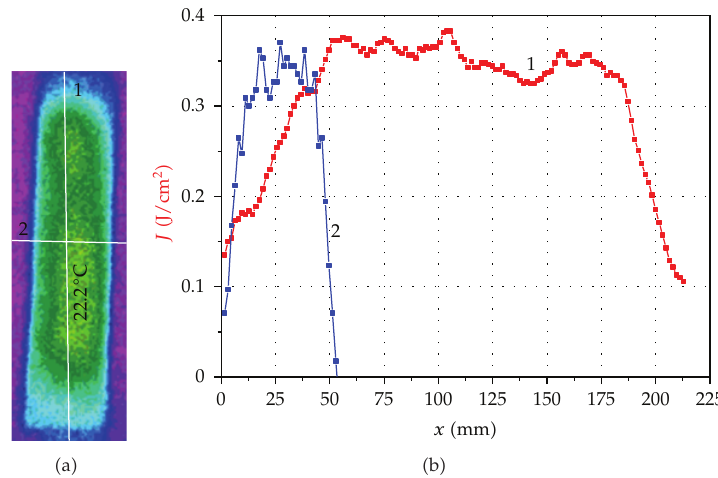
Figure 11: Thermal imprint (cid:2) a (cid:3) and ion beam energy density distribution at the target (cid:2) b (cid:3) in the vertical section (cid:2) 1 (cid:3) and horizontal section (cid:2) 2 (cid:3)